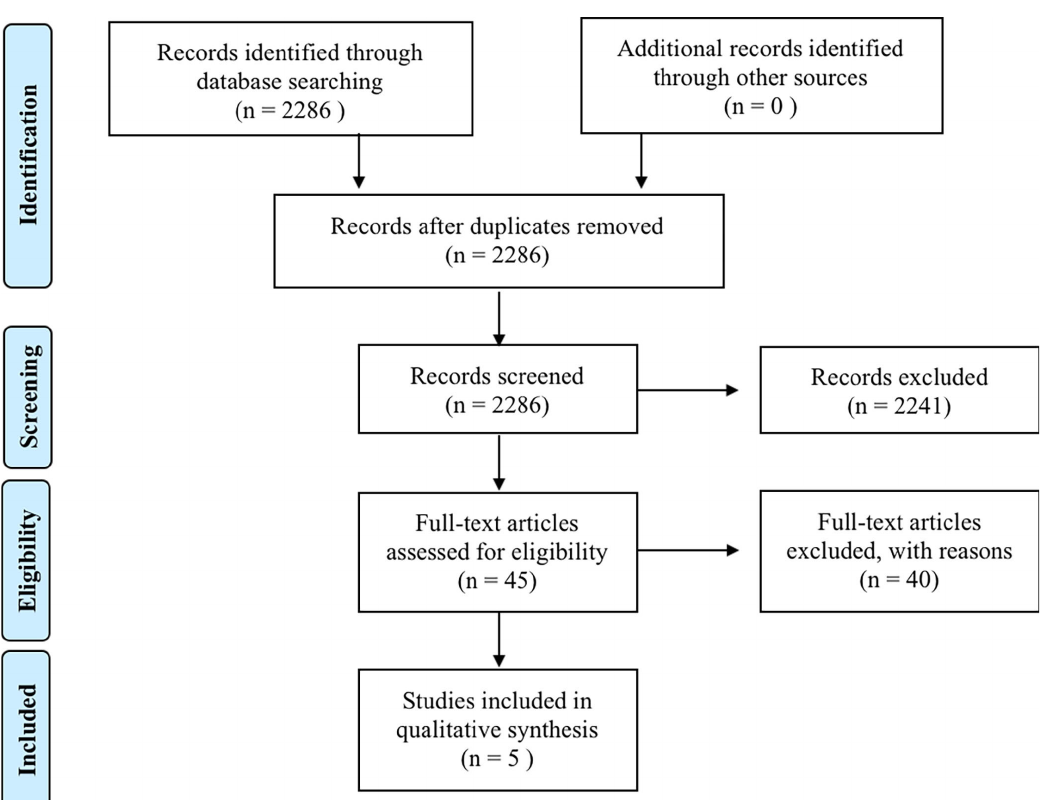
Figure. Literature search and article